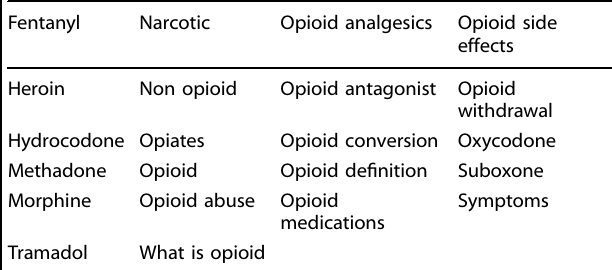
Table 3. The 22 opioid-related terms used to collect the Google Trends data, January 1, 2005 to Dec 31,